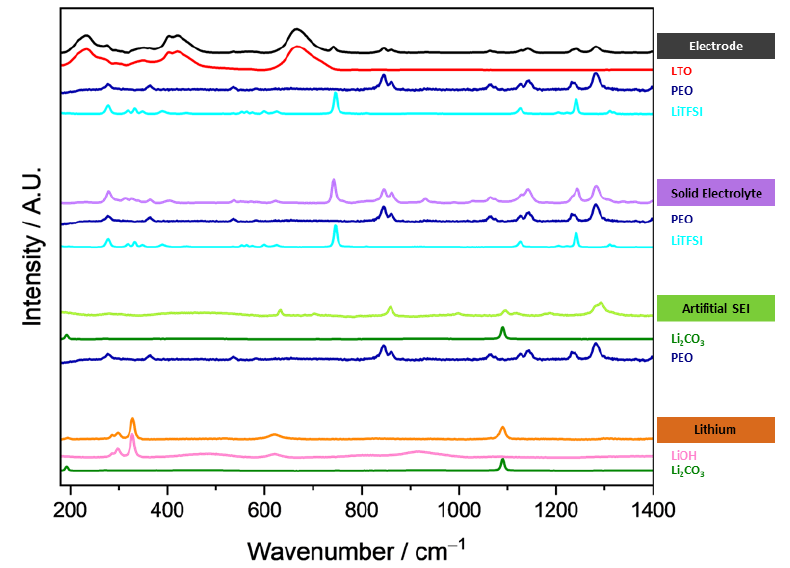
Figure 4. Spectra of each system component (electrode, black; solid electrolyte, purple; artificial SEI, light green; lithium, orange), compared with the signals of their constituents (electrode constituents: LTO, red; PEO, dark blue; LiTFSI, cyan; solid electrolyte constituents: PEO, dark blue; LiTFSI, cyan; artificial SEI constituents: Li 2 CO 3 , dark green; PEO, dark blue; lithium constituents: LiOH, pink; Li 2 CO 3 , dark green).